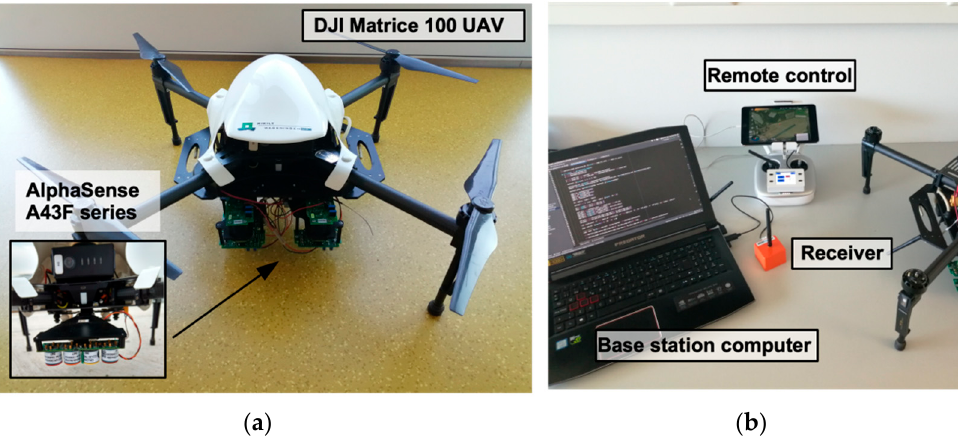
Figure 1. Unmanned Aerial Vehicle (UAV)-set up: ( a ) A top view of the DJI Matrice 100 UAV used during the experiments and a focus on the mounting point of the A43F series sensors, located underneath the drone. ( b ) The ground station, where the UAV was controlled and data was gathered and stored.